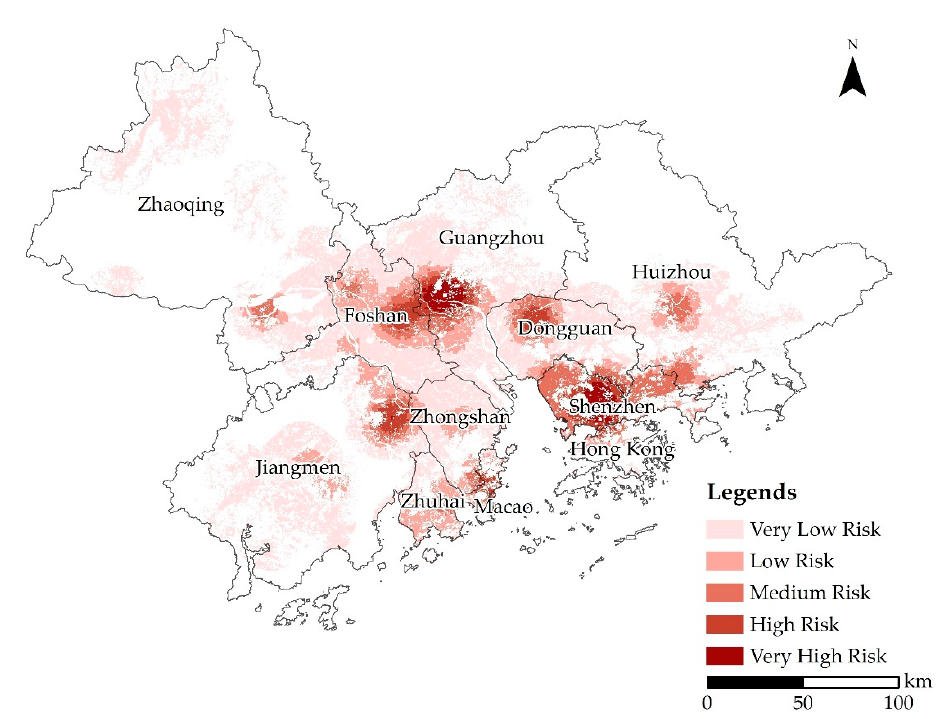
Figure 8. Spatial assessment of rainstorm waterlogging risk in the GBA based on the PCA-GWR model.